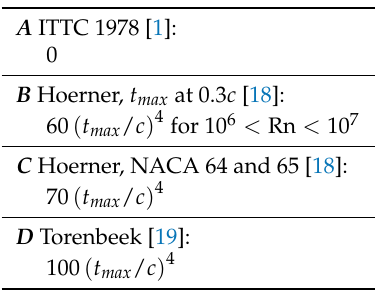
Table 4. Values for the relative pressure drag c P / ( 2 c F ) for symmetrical section profiles without flow separation mentioned in the literature. See also explanations given for Table